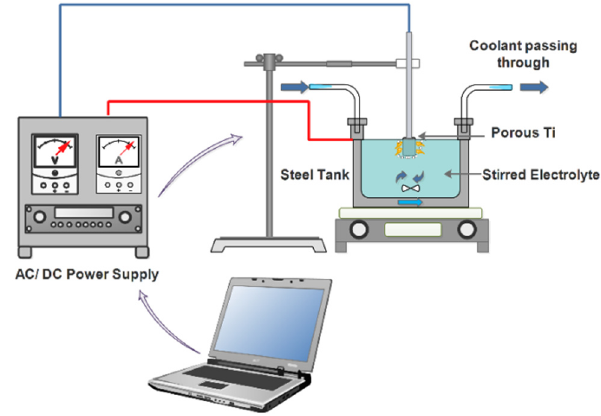
Figure 2. Schematic of the Plasma Electrolytic Oxidation (PEO) setup.